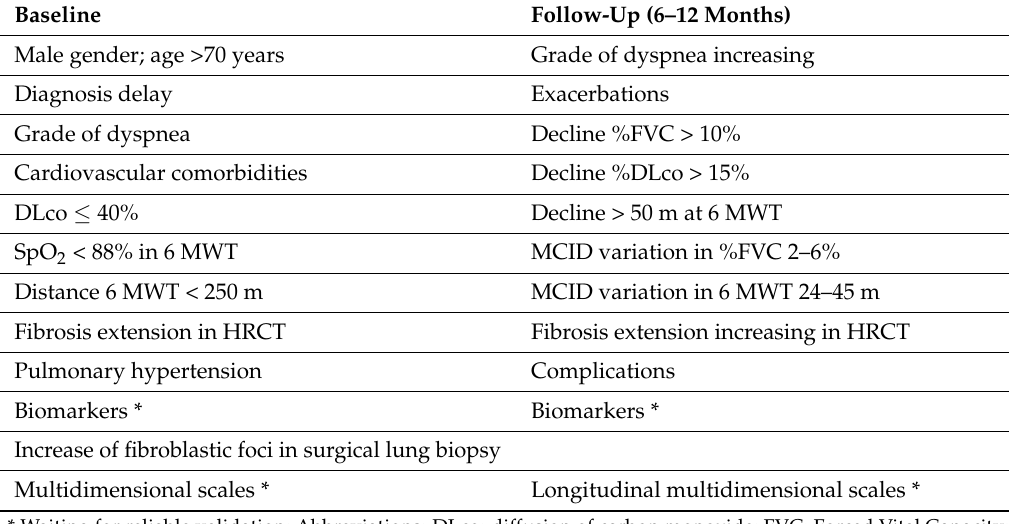
Table 1. Factors proved to be predictors of